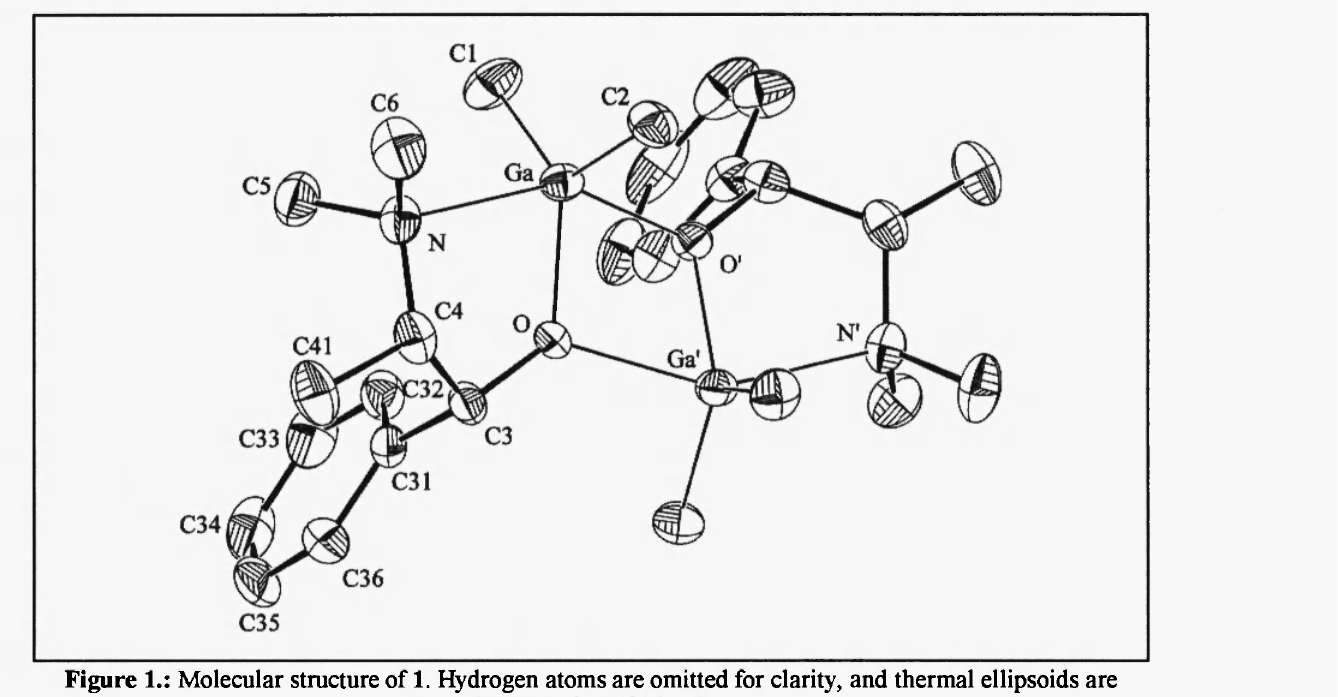
Figure 1.: Molecular structure of 1. Hydrogen atoms are omitted for clarity, and thermal ellipsoids are drawn at the 50%